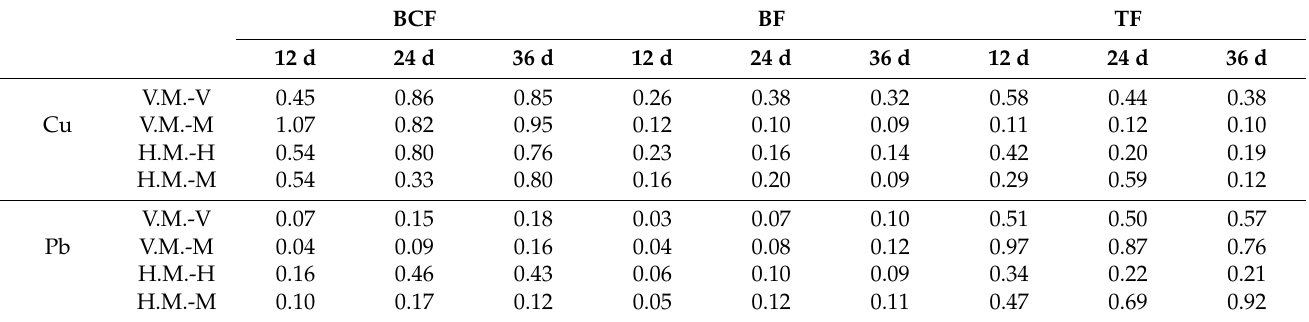
Table 4. BCF, TF and BF for